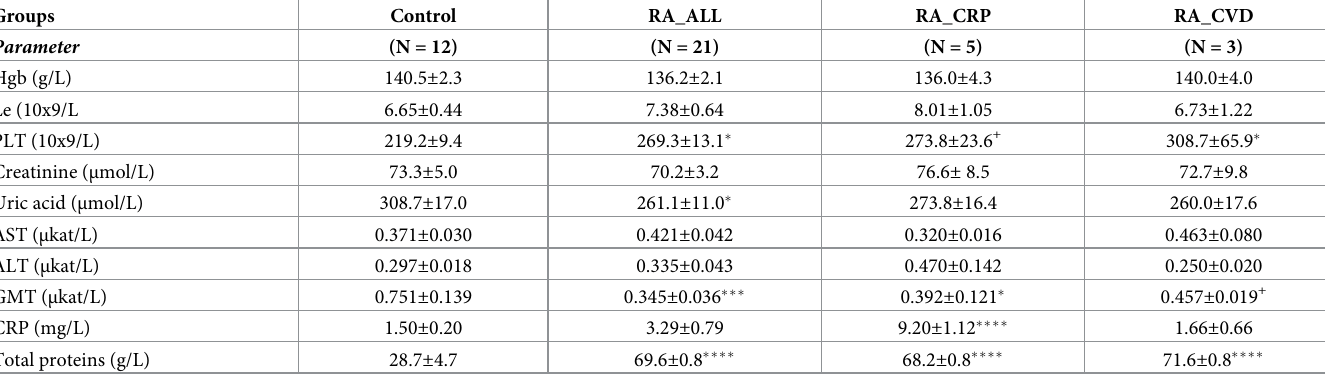
Table 1. Metabolic parameters of human volunteers and of RA patients. Groups Control RA_ALL